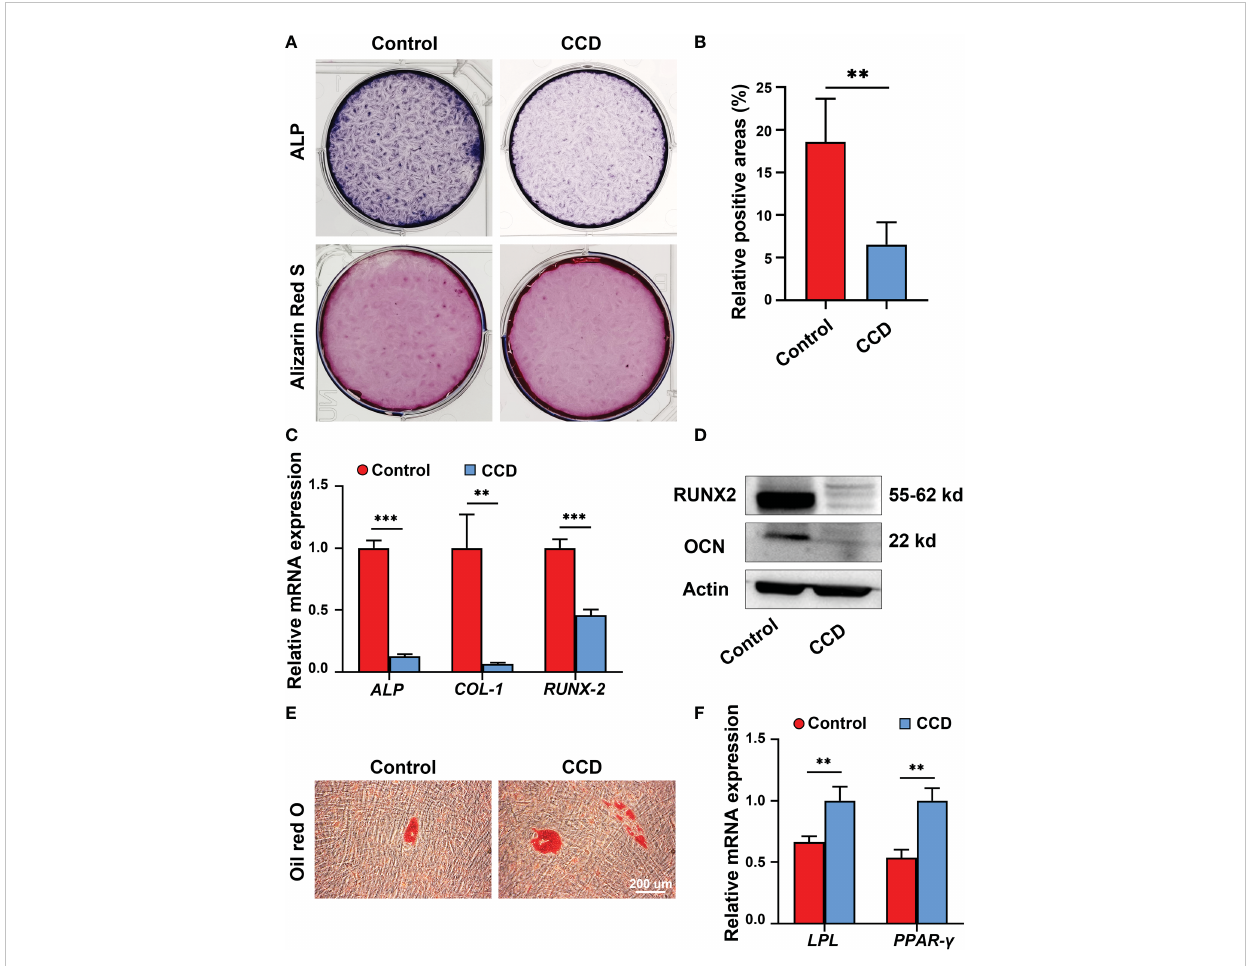
FIGURE 6 The impaired osteogenic potential of SHED from patients with CCD. (A) ALP and Alizarin Red S staining of SHED after osteogenic induction. (B) Alizarin Red S staining showing mineralized nodules obviously decreased in CCD group compared with the control group (n = 5, **p < 0.01). (C) qRT-PCR analysis of the expression of ALP, COL-1 , and RUNX2 after 14 d of osteogenic induction (n = 5, **p < 0.01, ***p < 0.001). (D) Western blot analysis showing OCN and RUNX2 protein expression levels in the two groups. Scale bar: 200 m m. (E) Oil red O staining of SHED after 7 d of adipogeneic induction. (F) qRT-PCR analysis of the expression of LPL and PPAR- g of SHED (n = 5, **p <